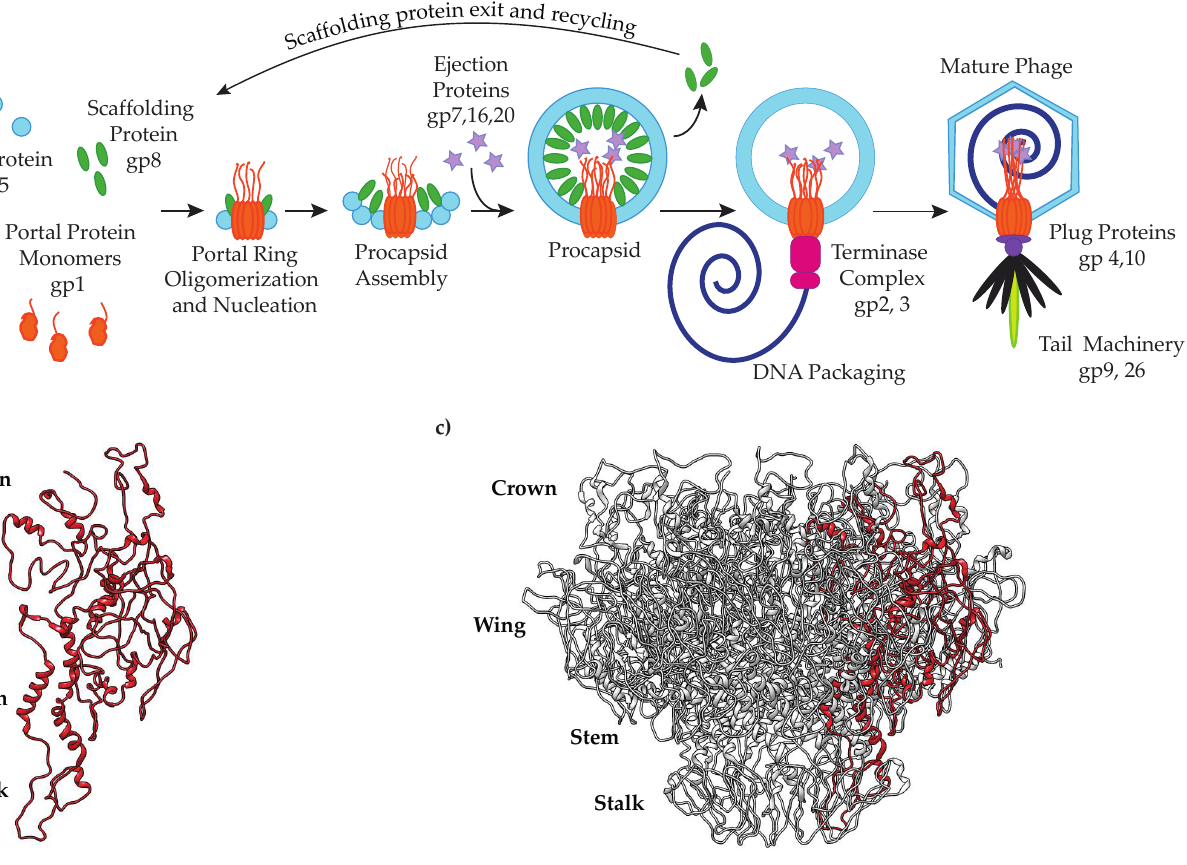
Figure 1. ( a ) Bacteriophage P22 assembly pathway; ( b ) single PC portal protein subunit; ( c ) PC portal protein complex (PDB: 5JJ1) [19].